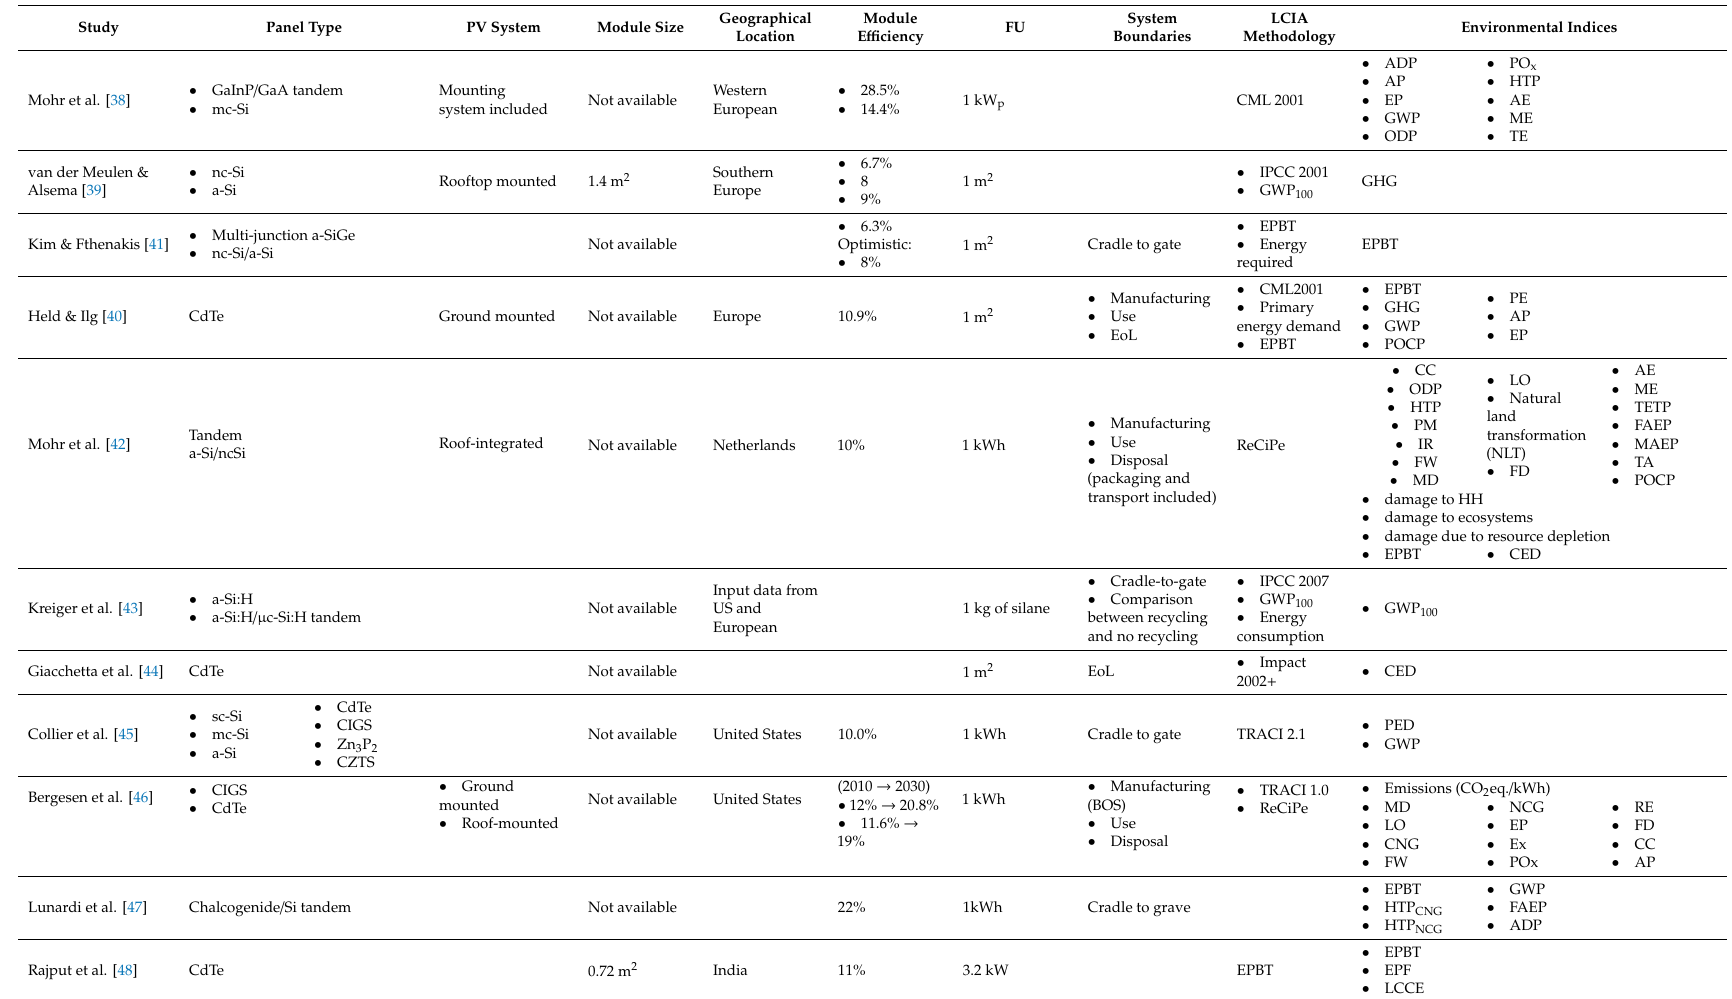
Table 11. Summary of key-parameters and methodological aspect of the examined case studies (second